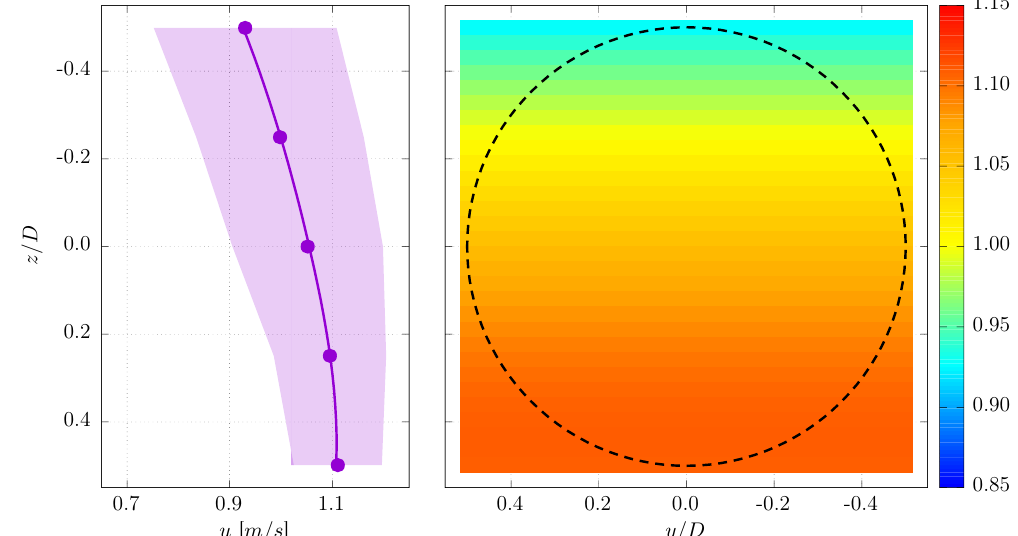
Figure 9. Disc-integrated velocity average: the Acoustic Doppler Velocimeter (ADV) measurements profile (case 6 at I FREMER flume tank) is spline fitted and extended in the transverse y direction (coloured plot). The spatial average is then processed on the turbine swept area (dashed black line). In this example, U ∞ = 1.047